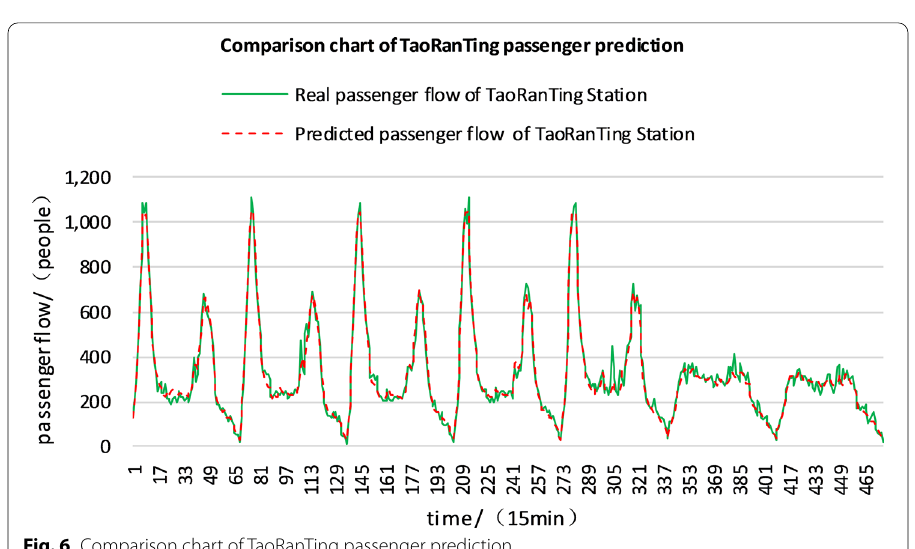
Fig. 6 Comparison chart of TaoRanTing passenger